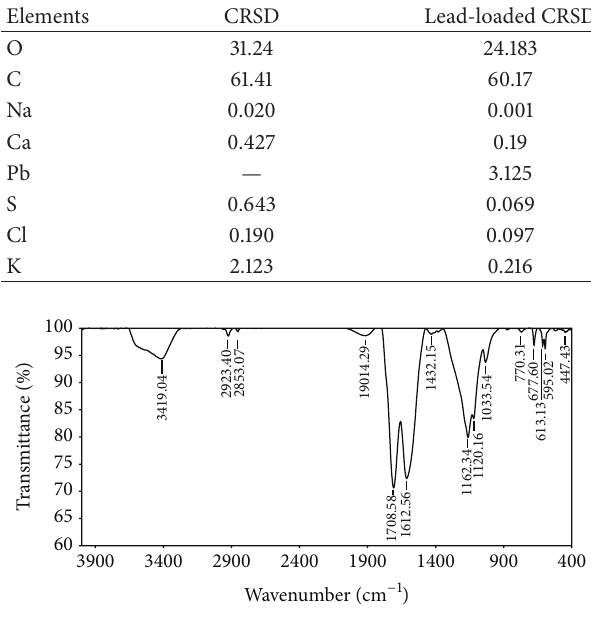
Figure 1: FTIR spectra of CRSD.